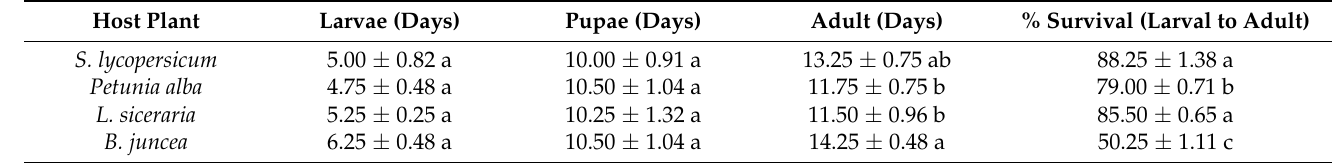
Table 2. Mean ( ± SE) for traits under study in leaves of four host plants.